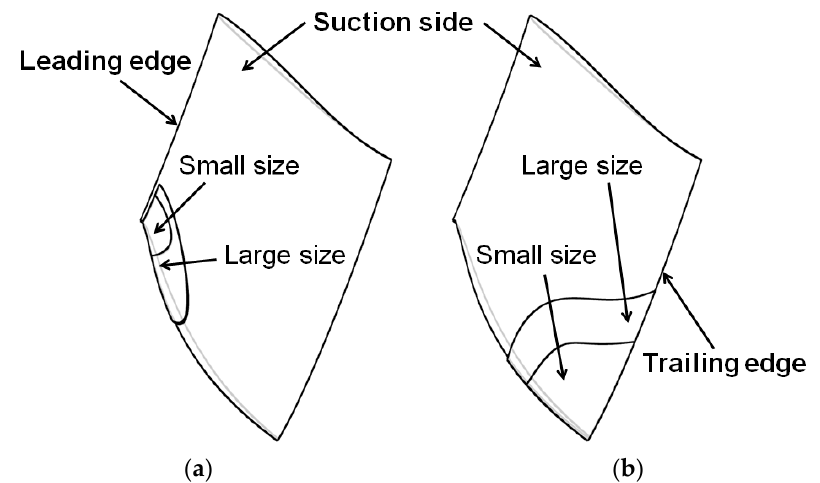
Figure 2. ( a ) Sizes and locations of the simulated leading edge cavitation on the single blade; ( b ) sizes and locations of the simulated trailing edge cavitation on the single blade.